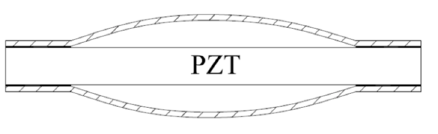
Figure 25. Structure diagram of cymbal with spherical end cap.